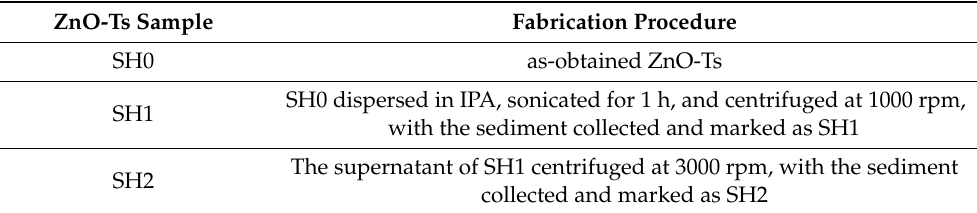
Table 4. Fabrication procedures of the ZnO-T